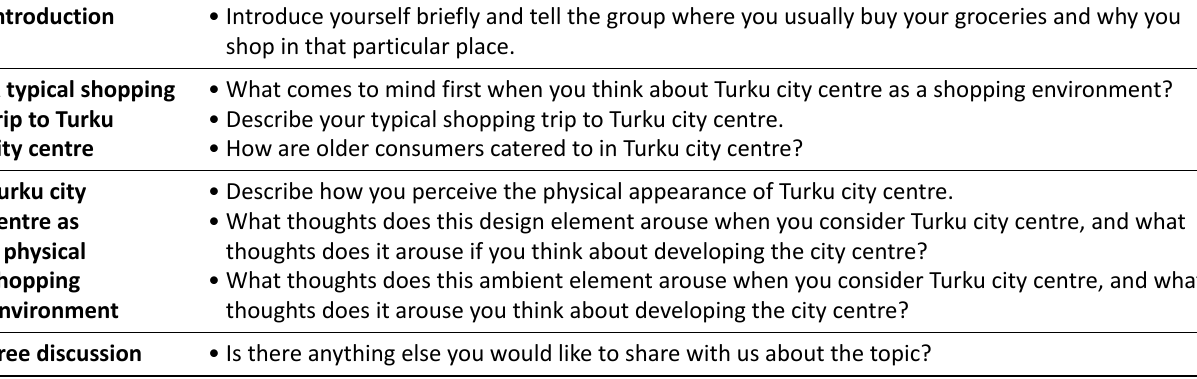
Table 2. The pre-formulated themes of the focus-group